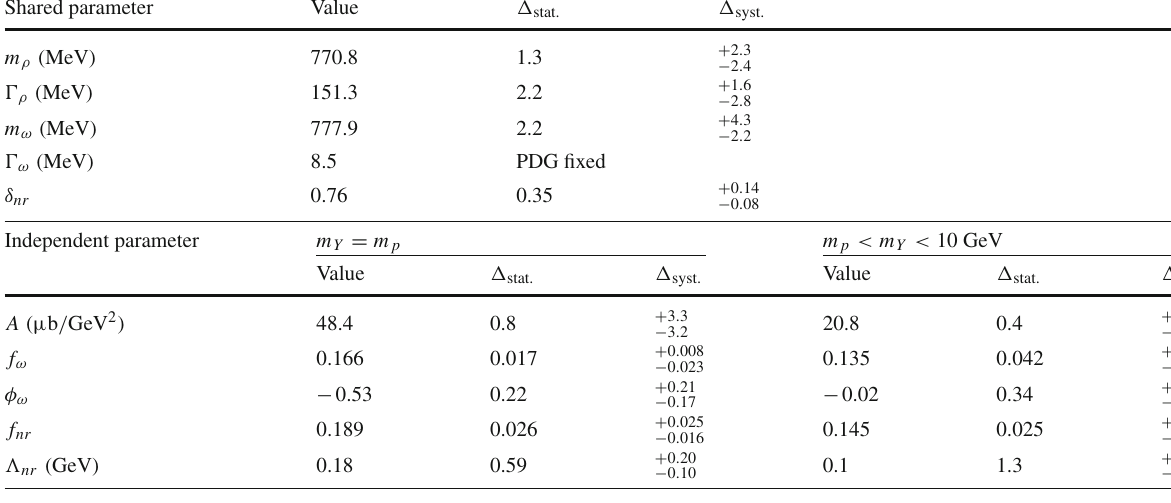
Fig. 7 Elastic ( m Y = m p ) ( a ) and proton-dissociative ( m p < m Y < 10 GeV) ( b ) differential π + π − photoproduction cross sections d σ(γ p → π + π − Y )/ d m ππ as functions of m ππ . Equation (18) is fitted to the distributions in the mass region 0 . 6 GeV ≤ m ππ ≤ 1 . 0 GeV as described in the text. The model and its components are displayed as indicated in the legend. In the ratio panel, the data are compared to the bin-averaged fit function values as they entered in the χ 2 calculation for the